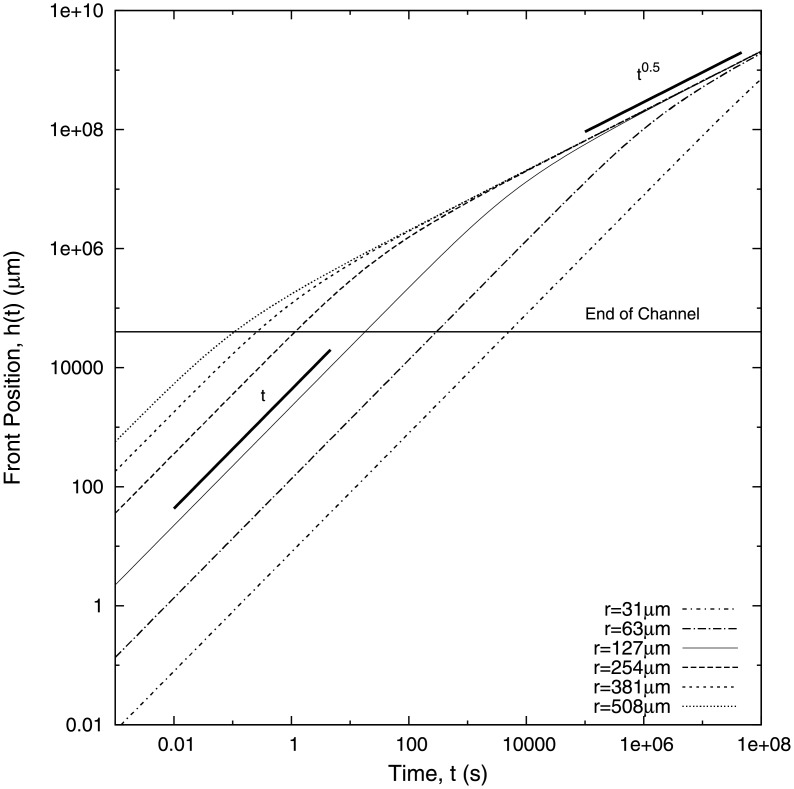
Theoretical front position h(t) for different values of the radius of the microtube r, Eq (9), for water.The value of r = 127 μm (solid line) corresponds to the radius used in the experimental setup. The thick lines represent t0.5 and t growth exponents. The geometrical parameters used in the plot are those of the experimental setup. The pressure used is ρgH − Pcap = 3000Pa.